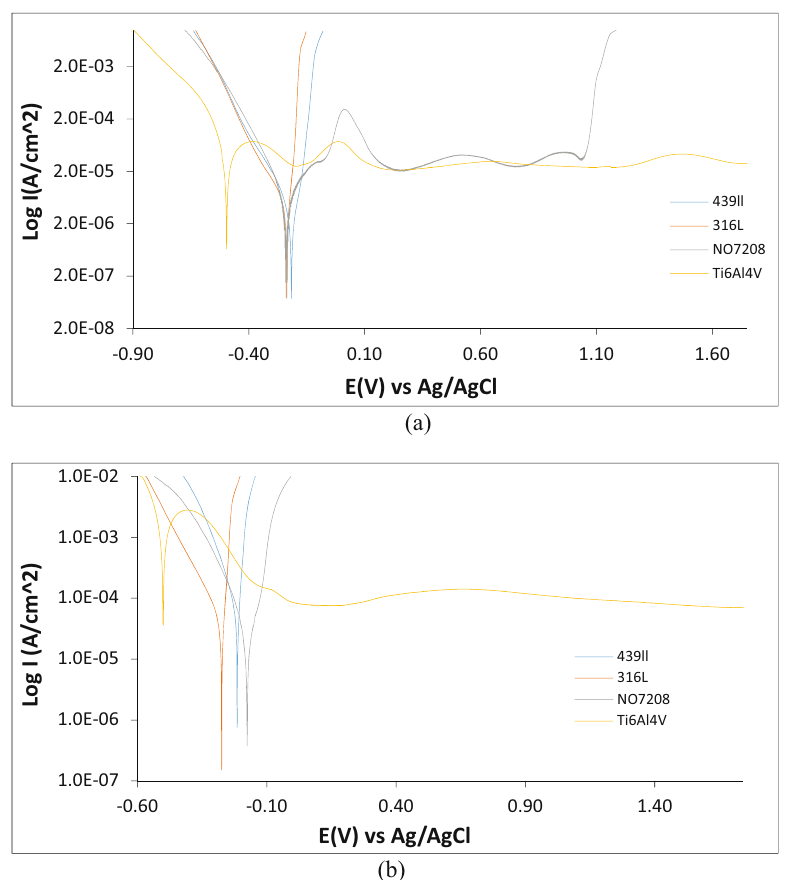
Figure 1: Corrosion polarization plots of 439ll, 316L, NO7208, and Ti6Al4V alloys in 4 M H 2 SO 4 + 5% NaCl solution at ( a ) 35°C and ( b ) 70°C.